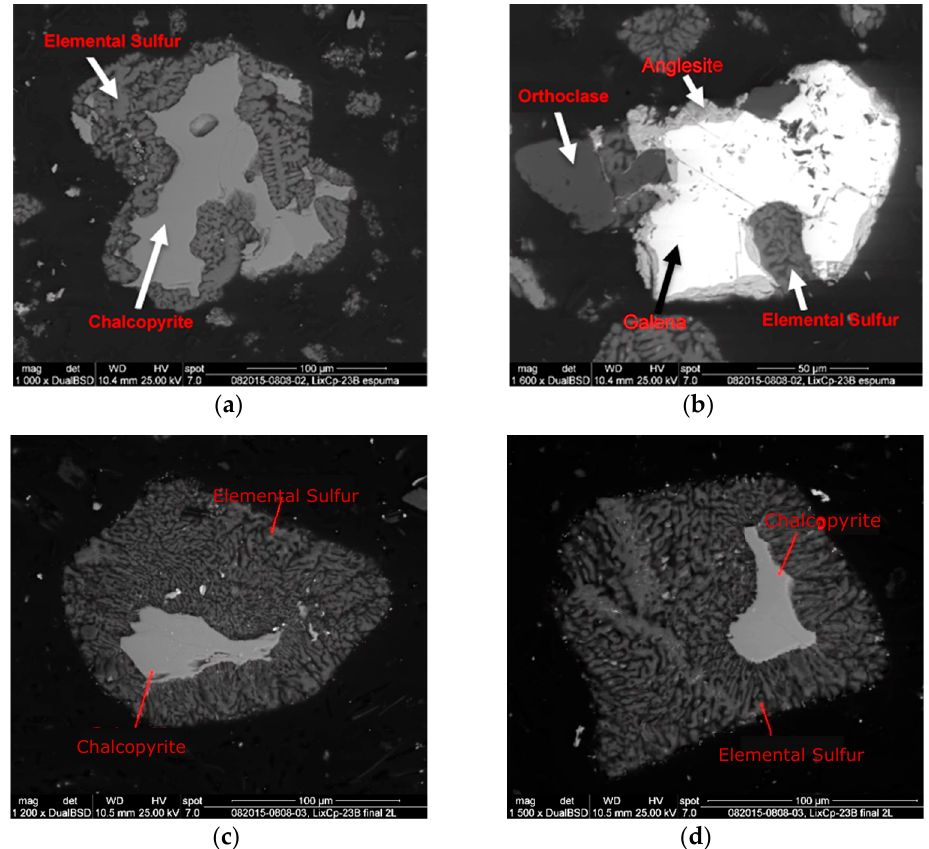
Figure 4. Punctual microanalysis by SEM-BSE-EDS in the leached residue of test P5. ( a ) Unreacted chalcopyrite particle, ( b ) unreacted galena particle, ( c ) unreacted Chalcopyrite particle, ( d ) unreacted Chalcopyrite particle.